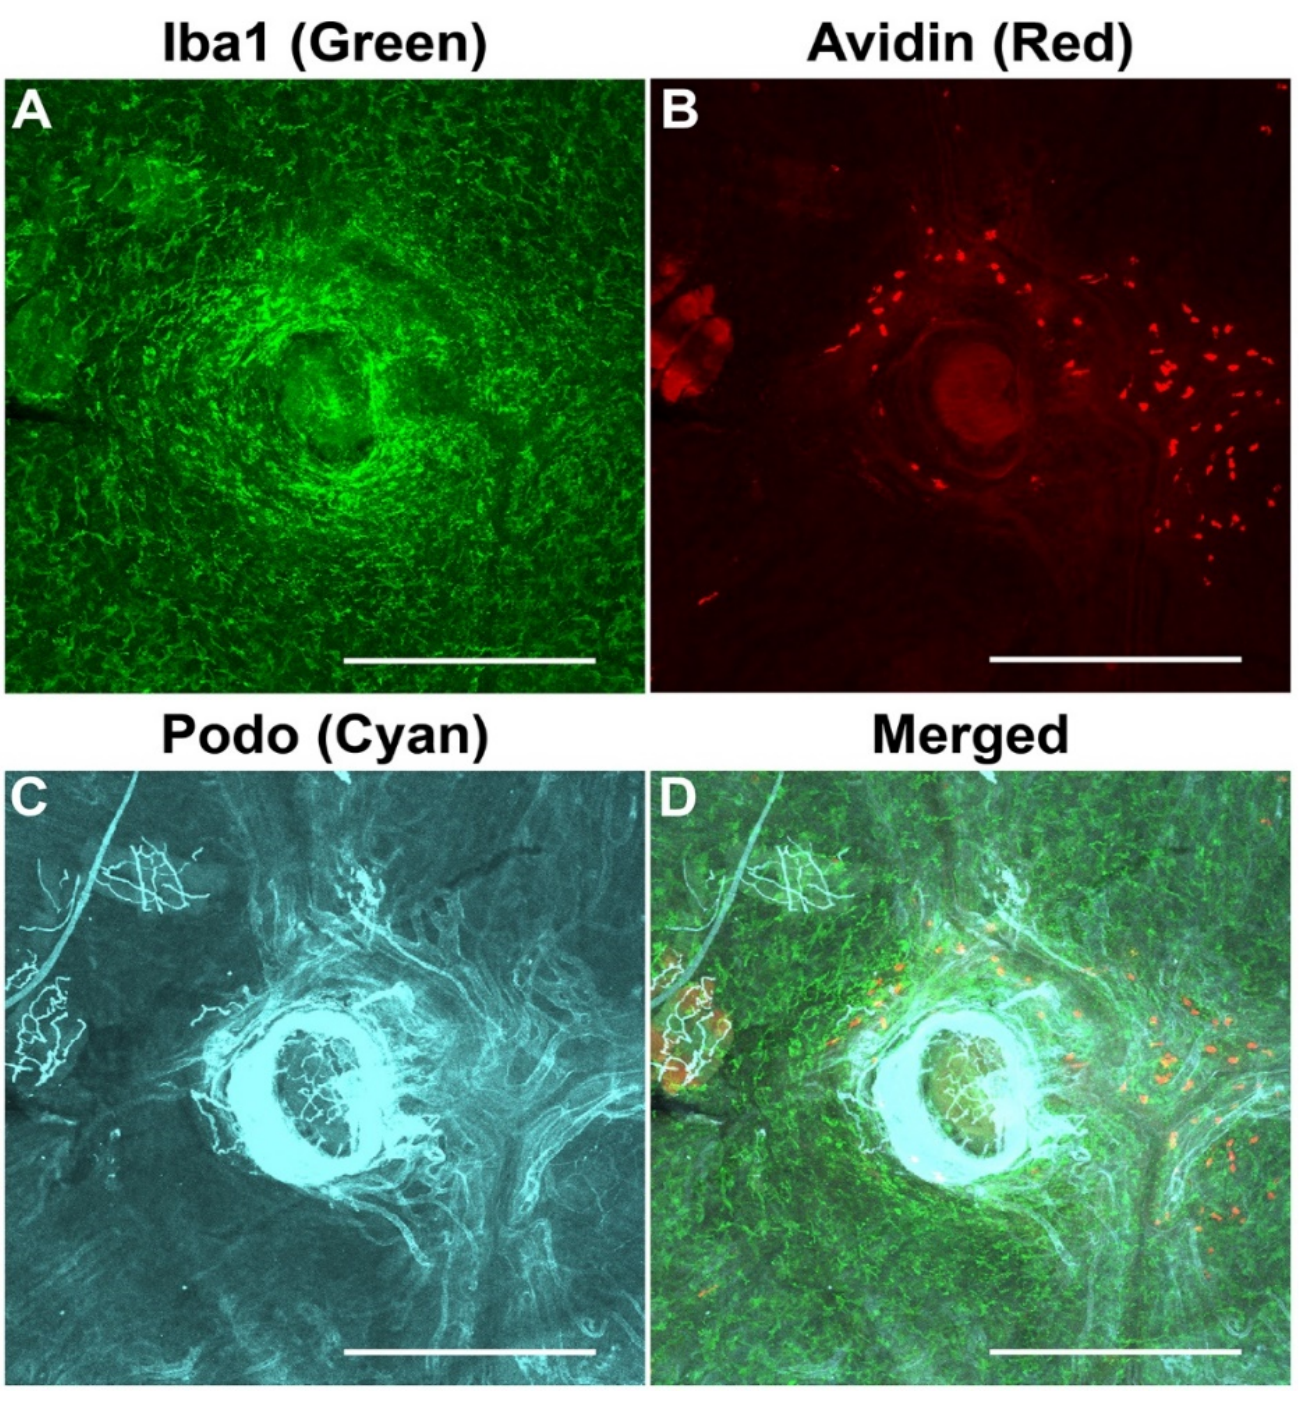
Figure 7. Co-visualization of blood vessels, mast cells, and macrophages in the choroid of pigmented mice. Macrophages, mast cells, and blood vessels in the choroid were labeled with anti-Iba1 antibody, rhodamine-avidin, and anti-podocalyxin, respectively. Representative images from stained and bleached mouse choroid showed robust labeling of macrophages ( A ), mast cells ( B ), and blood vessels ( C ). In addition, merged images ( D ) showed each targeted cell type with respect to other types of cells/blood vessels of the choroid. All representative images were from 6-week-old C57BL/6J animals and captured using confocal microscopy. Number of choroids examined = 9. Scale bars: 500 μ m.